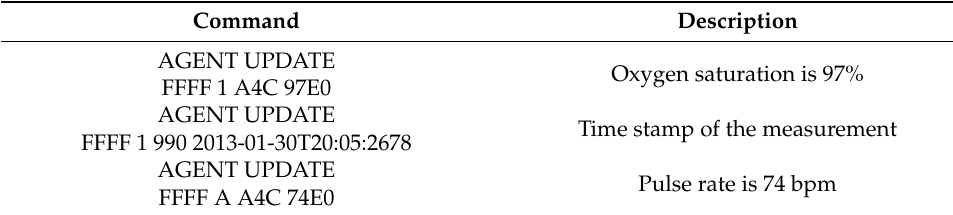
Table 1. Example of iWrap syntax to send pulse oximeter